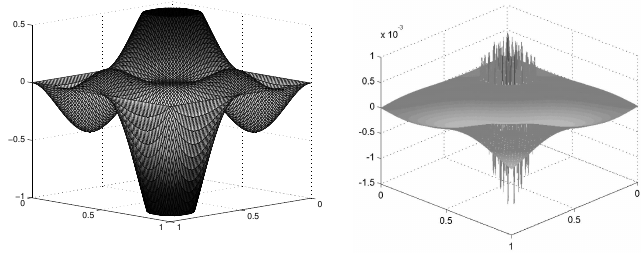
Figure 4. The exact solution u (left) and the error u − u h (right), Example 2.